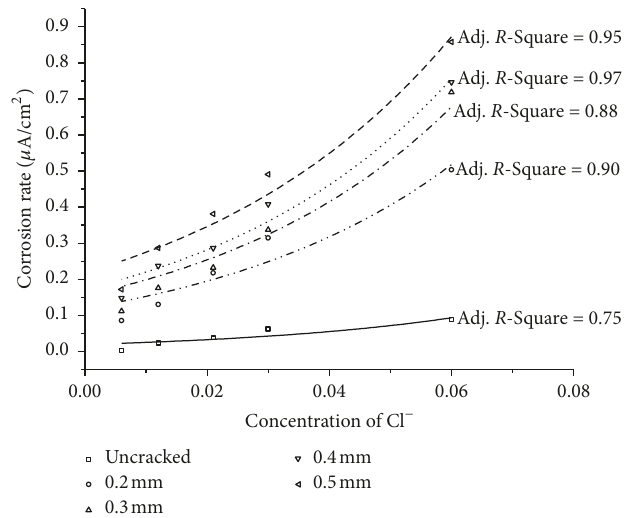
Figure 6: Average corrosion rates versus concentration of chloride solution.